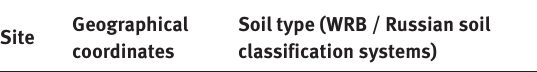
Table 1: Description of the study plots in Salekhard and the